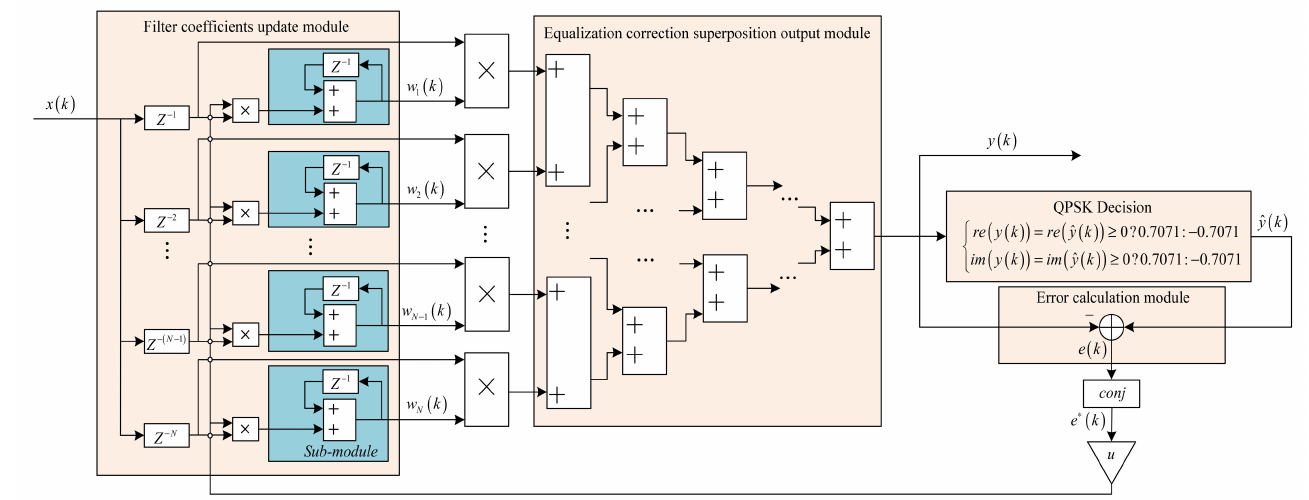
Figure 4. Structure diagram of the VM-DDLMS algorithm. e *( k ) is the conjugate of e ( k ).